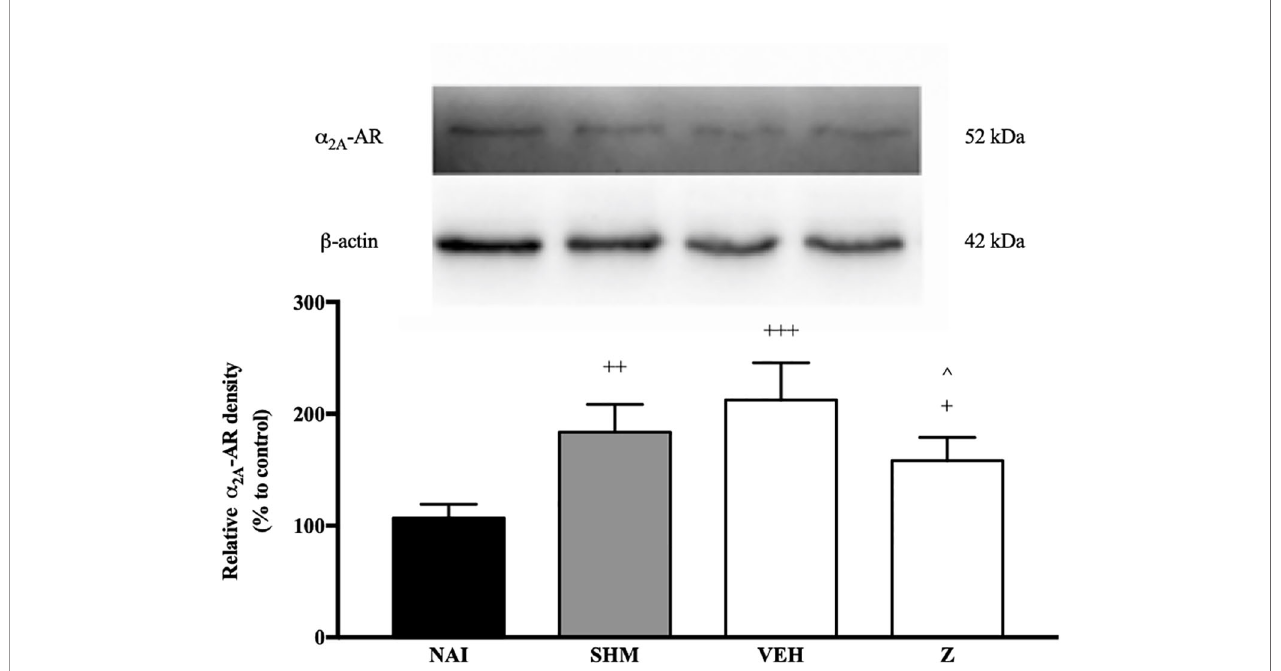
FIGURE 7 | Representative western blots of a 2A -adrenergic receptor from brain samples of naïve, sham, vehicle and zerumbone-treated groups. Data presented as mean ± SEM (n = 4), which were normalized to b -actin. + p < 0.05, ++ p < 0.01, +++ p < 0.001 as compared to naïve and ^ p < 0.05 as compared to vehicle group. NAI (Naïve); SHM (Sham); VEH (Vehicle, 10 mL/kg); Z (Zerumbone, 10 mg/kg).